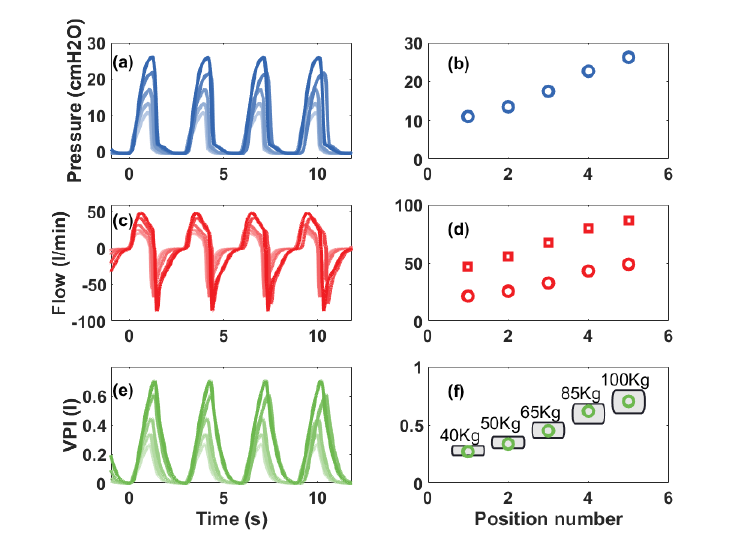
Figure 4. eARM measurement results. ( a ) Pressure as a function of time for microswitch positions 1 (lighter color) to 5 (darker color). ( b ) Peak pressure from plots in ( a ) as a function of microswitch position. ( c ) Flow generated as a function of time for microswitch positions 1 (lighter color) to 5 (darker color). ( d ) Peak inspiratory (circles) and expiratory flow (squares) as a function of microswitch position. ( e ) Volume pumped as a function of time for microswitch positions 1 (lighter color) to 5 (darker color). ( f ) Peak volume pumped for the various microswitch positions, the gray boxes show the recommended tidal volumes (6 to 8 mL/kg) for various predicted body weights (ideal weights).